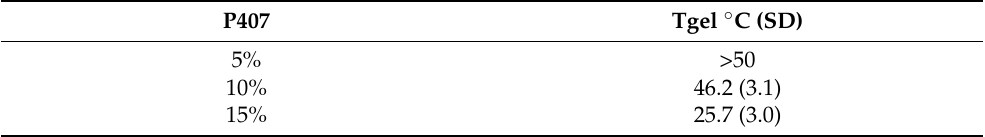
Table 3. Effect of the P407 concentration on the Tgel of different empty TSH formulations with 0.5% HA330.